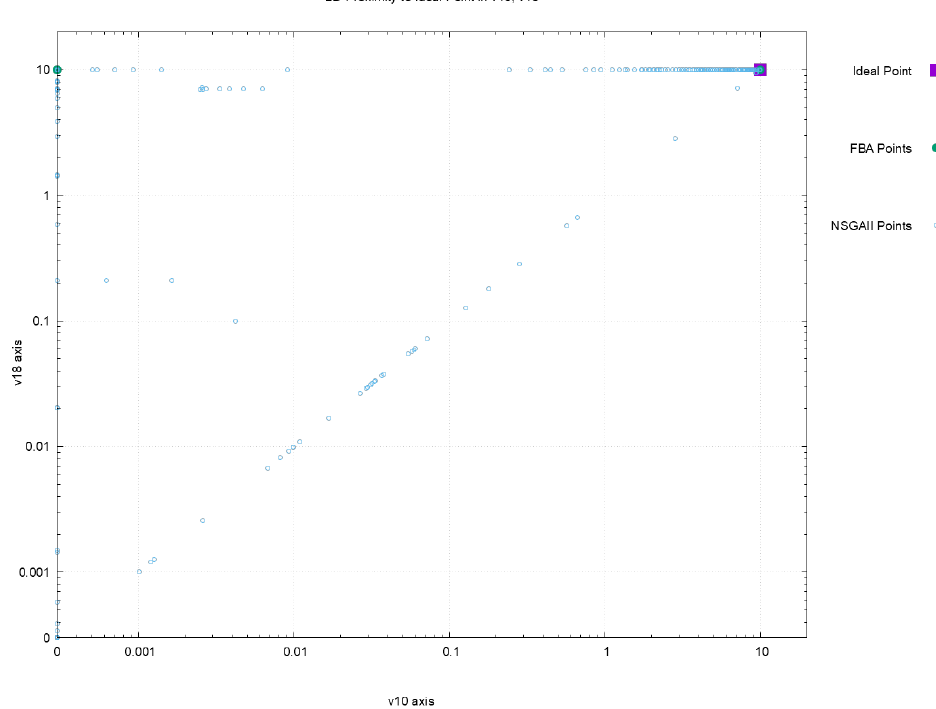
Figure 4. Pareto approximation for configuration C 0 with respect to the plane formed by objectives ( v ) 10 , v 18